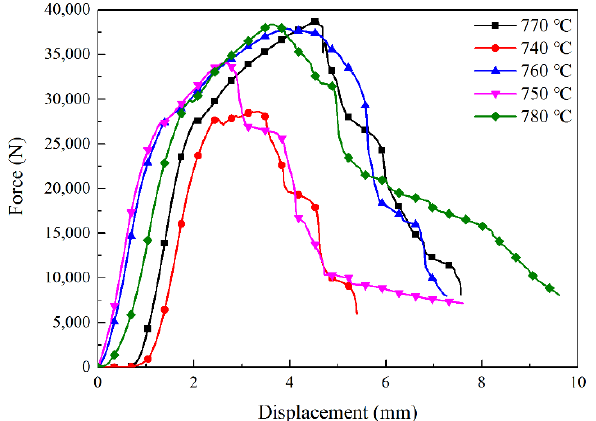
Figure 7. Diagram of the force–displacement relationship in the three-point bending load test of the SD/Cu-Fe sandwich composite.